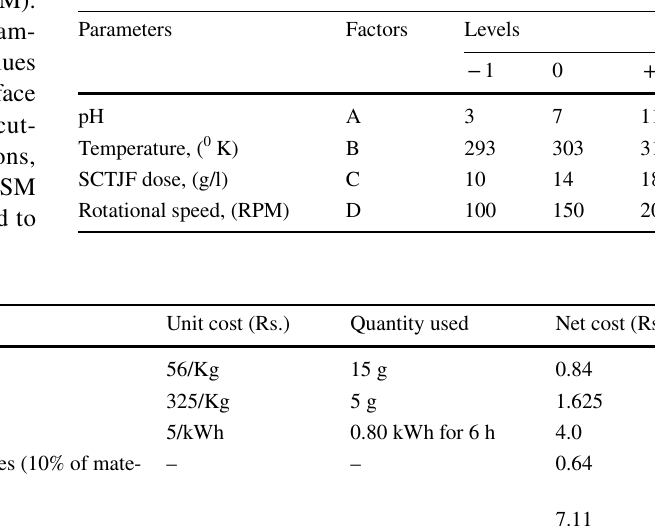
Table 5 Experimental operating parameters with range of levels